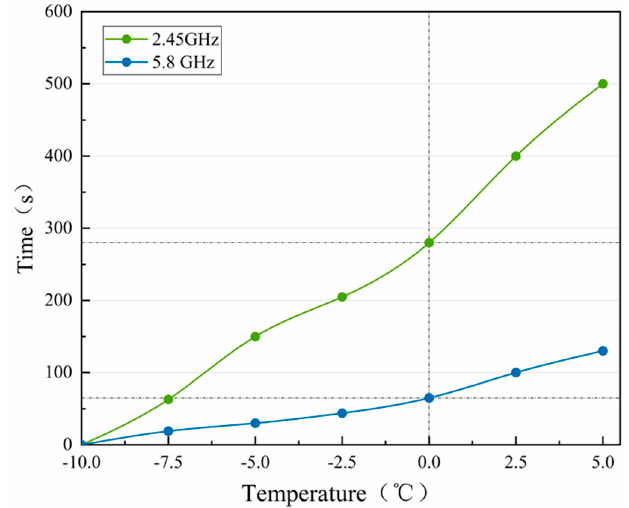
Figure 6. Comparison of temperature changes at different frequencies at point G.